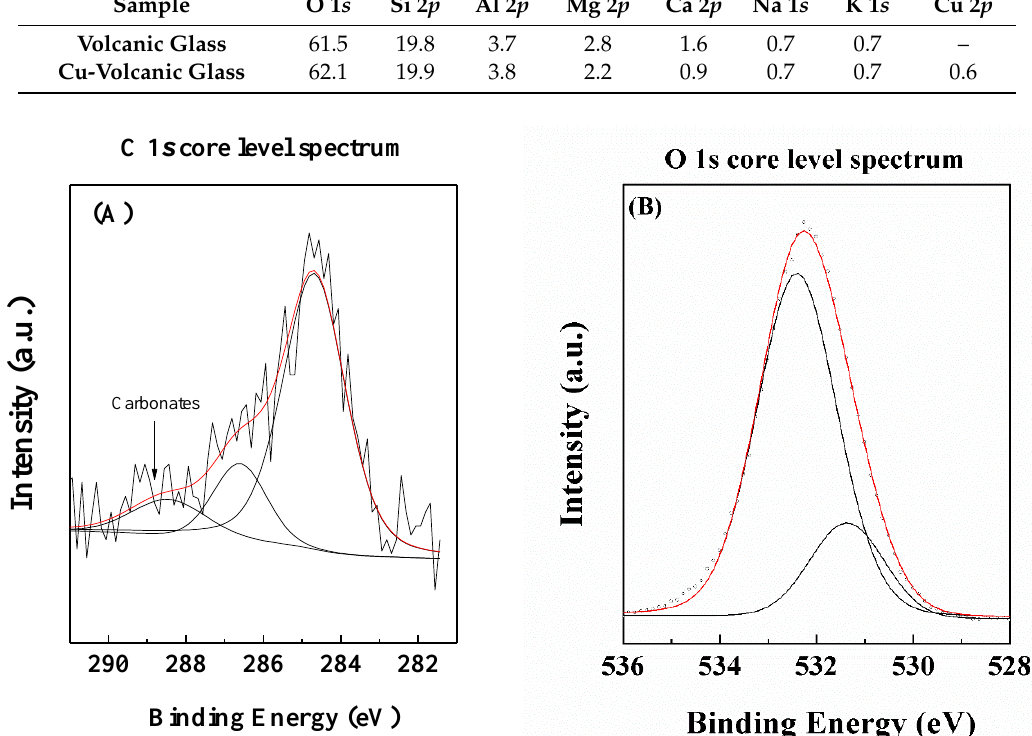
Figure 2. C 1 s core level spectrum and O 1 s core level spectrum of Cu-volcanic glass.